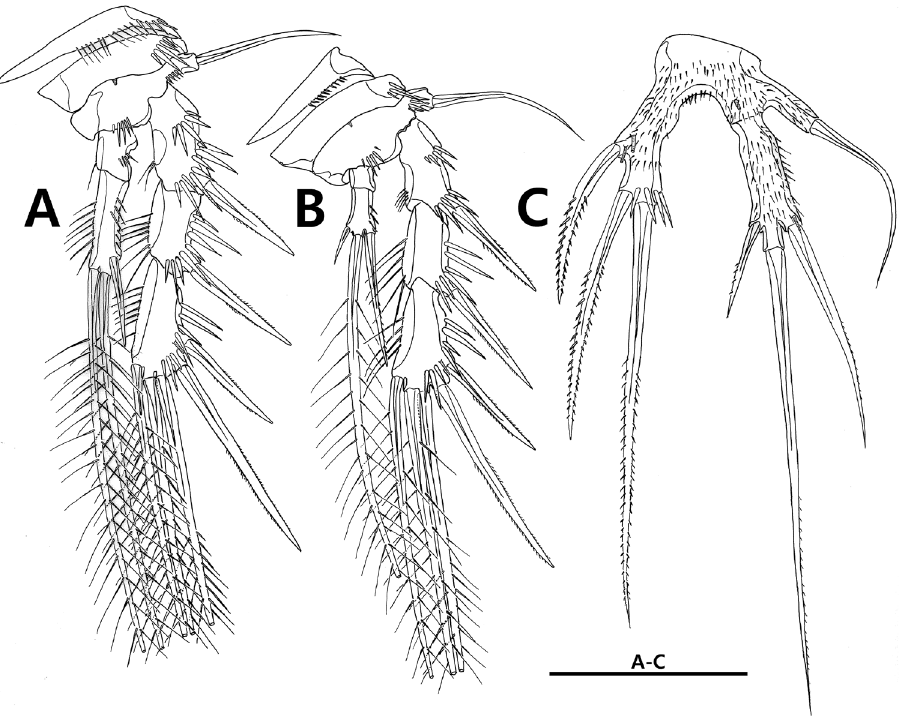
Figure 5. Strongylacron glabrum sp. n. female. A P3 B P4 C P5. Scale bar 50